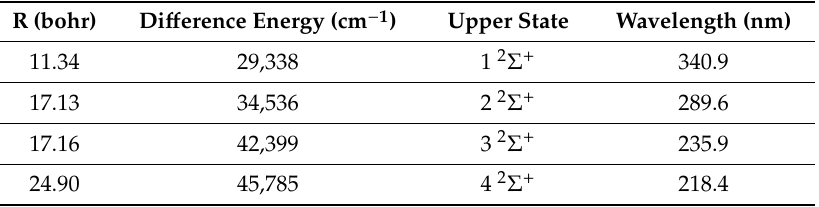
Table 2. Minima in the di ff erence potentials N 2 Σ + ( KCs + ) − X 1 Σ + ( KCs )